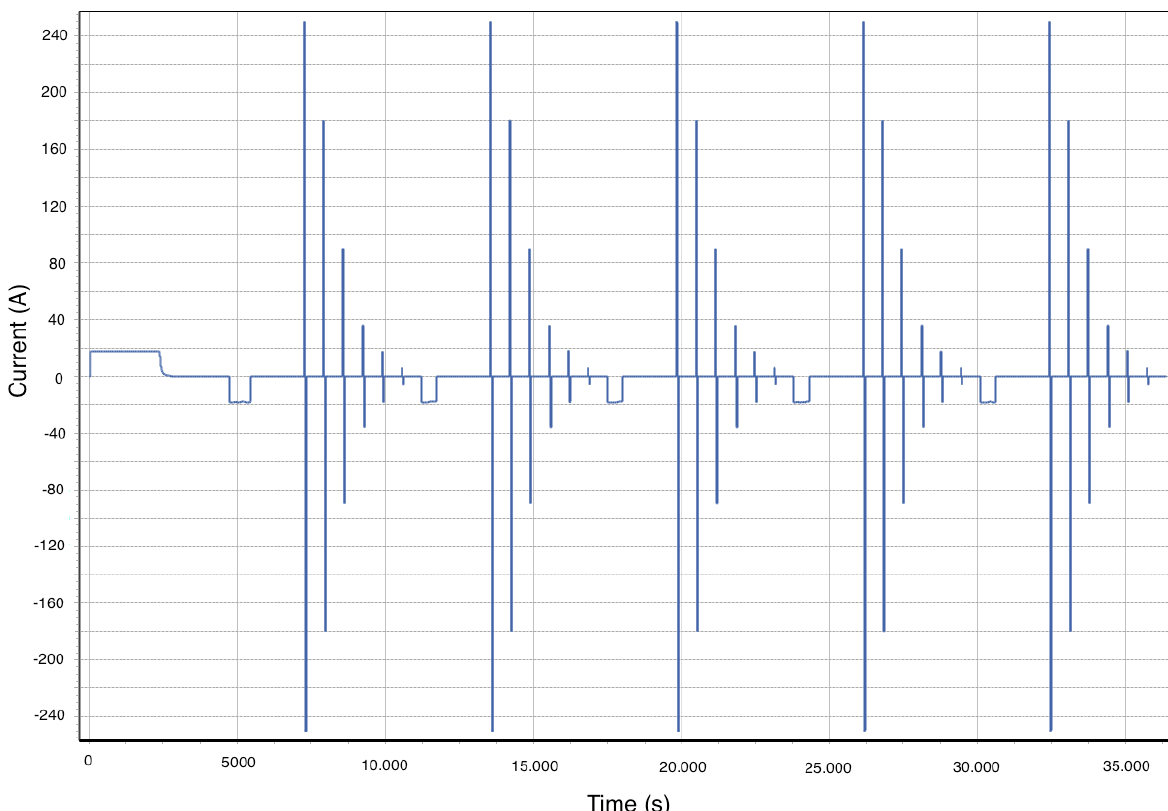
Figure 9. Extended Hybrid Pulse Power Characterization